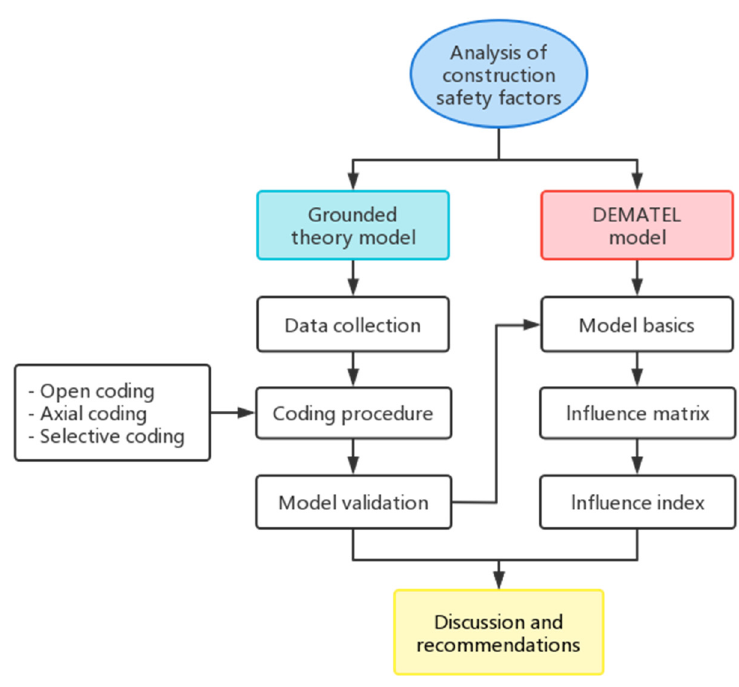
Figure 1. Study methodology.